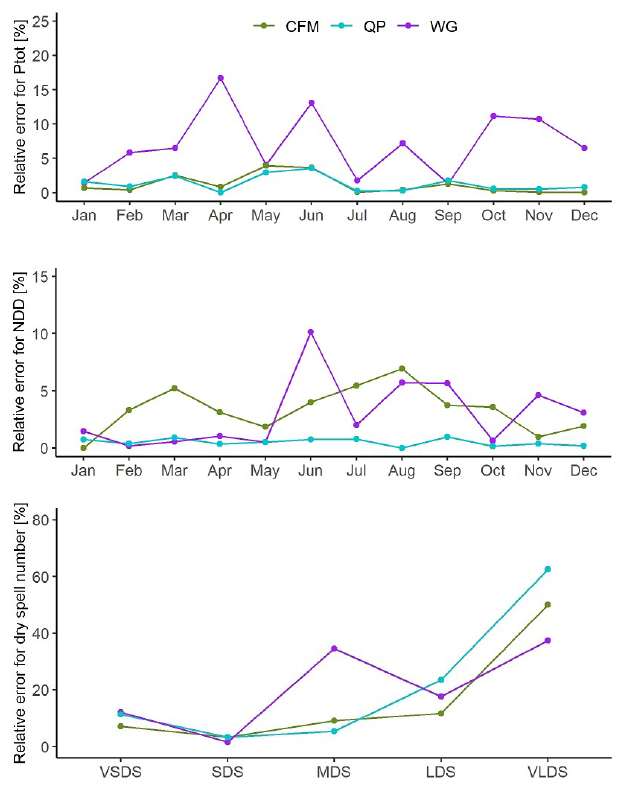
Figure 3. Relative error of the observation-based cross-validation for the drought-related indicators (Ptot – monthly precipitation; NDD – number of dry days; dry spell number). Each colour rep- resents a downscaling method. VSDS, SDS, MDS, LDS and VLDS denote the very short, short, medium, long and very long dry spells defined in Table 4,